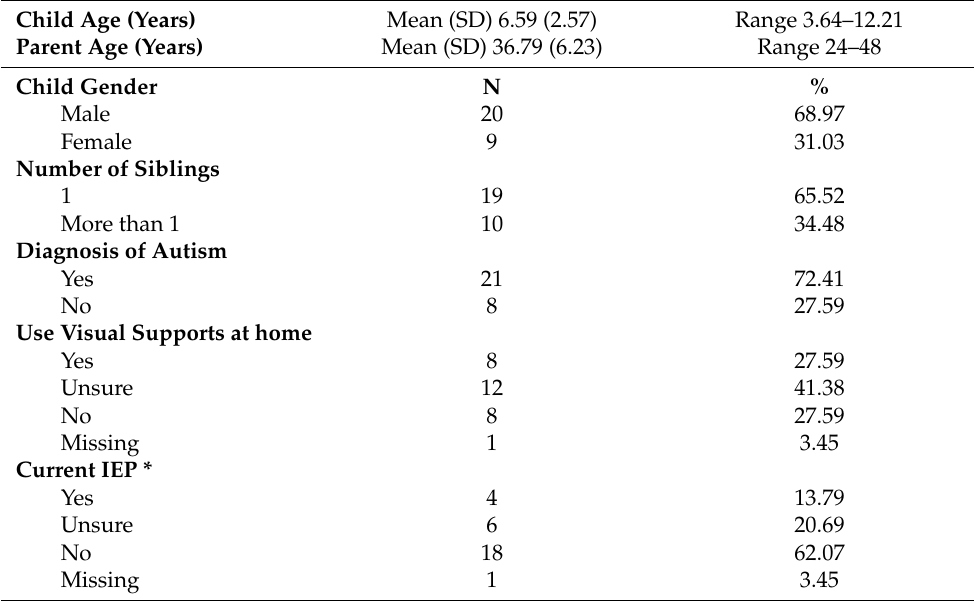
Table 2. Participant demographics (n =